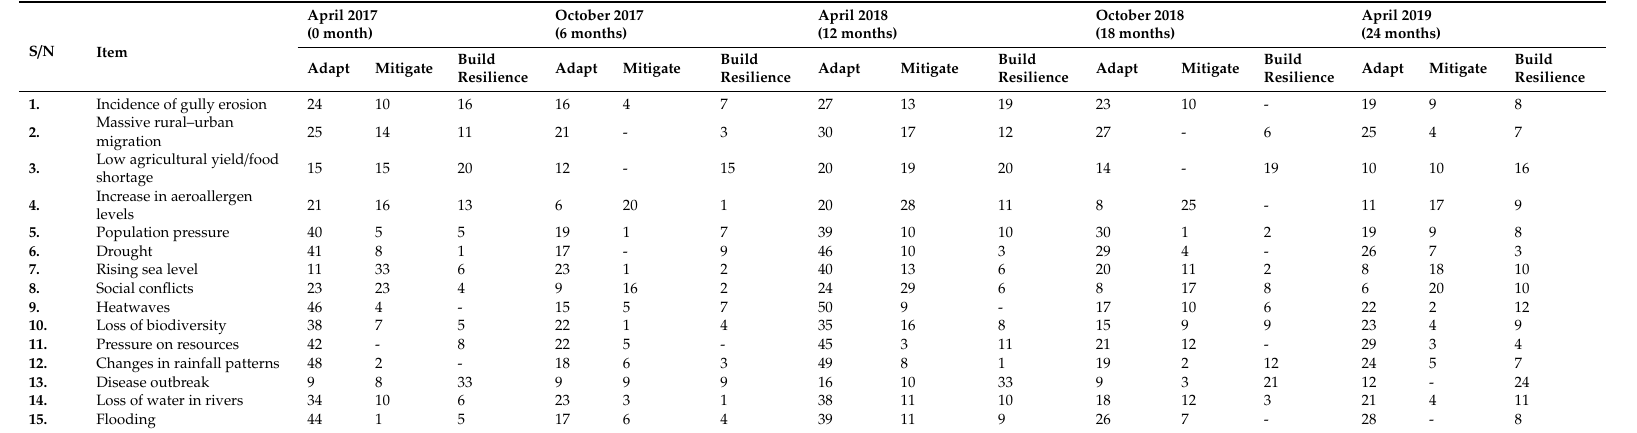
Table A1. Breakdown of questionnaire results for CC challenges in Nigeria.